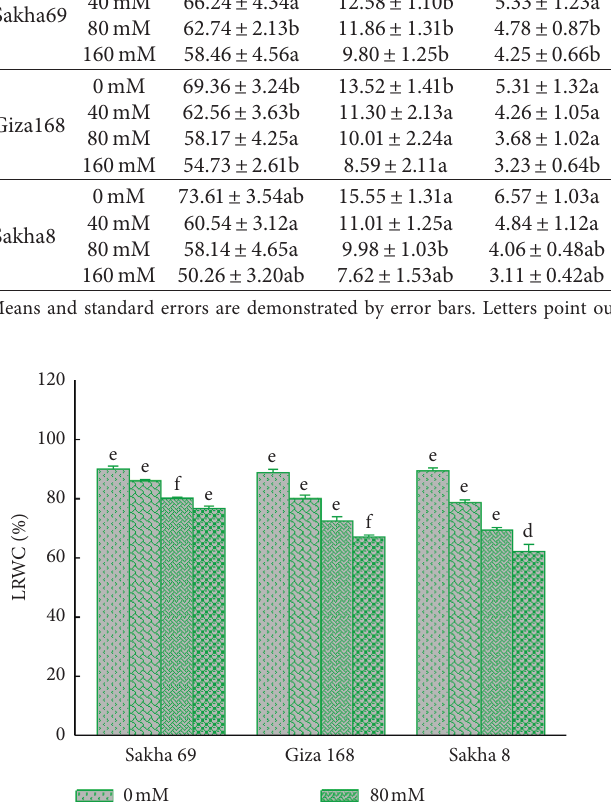
Table 1: Impact of salinity concentrations on growth criteria (shoot and root) of wheat cultivars. Wheat